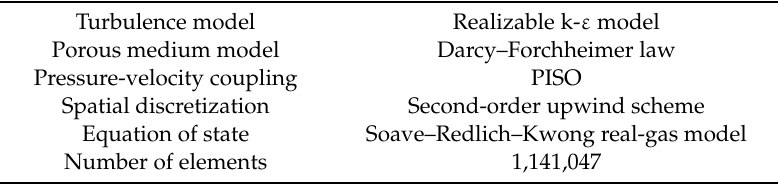
Table 1. Computational fluid dynamics (CFD) simulation